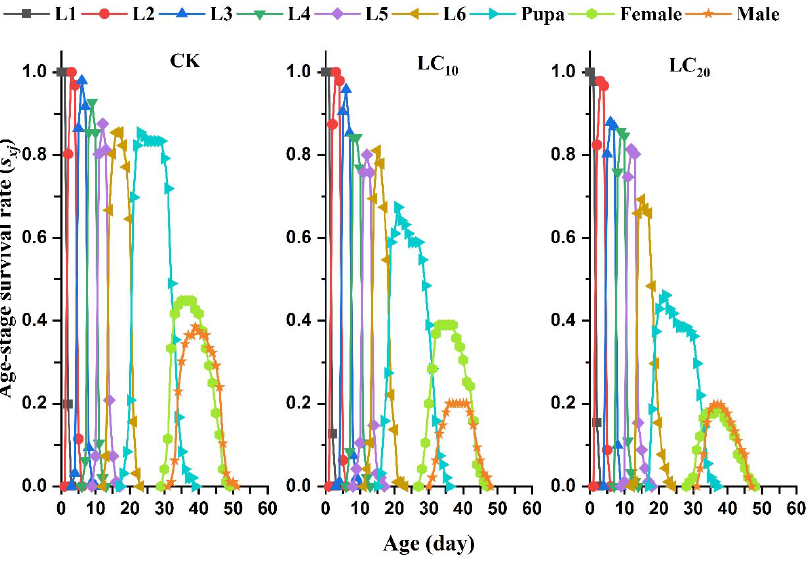
Figure 1. Age-stage specific survival rate ( S xj ) of FAW exposed to sublethal concentrations (LC 10 and LC 20 ).